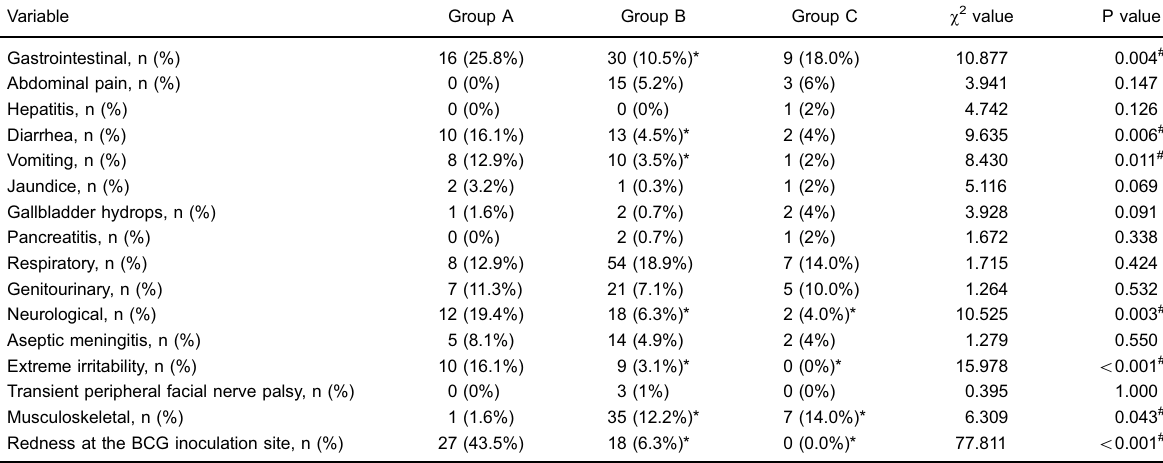
Table 2. Other clinical fi ndings in the different Kawasaki disease age groups.